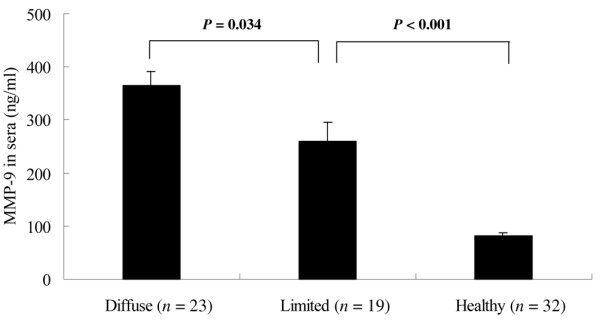
Concentrations of circulating matrix metalloproteinase-9 (MMP-9) in patients with diffuse (n = 23) or limited (n = 19) systemic sclerosis and in healthy controls (n = 32). Data are presented as means ± standard error of the mean (Mann–Whitney rank sum test).